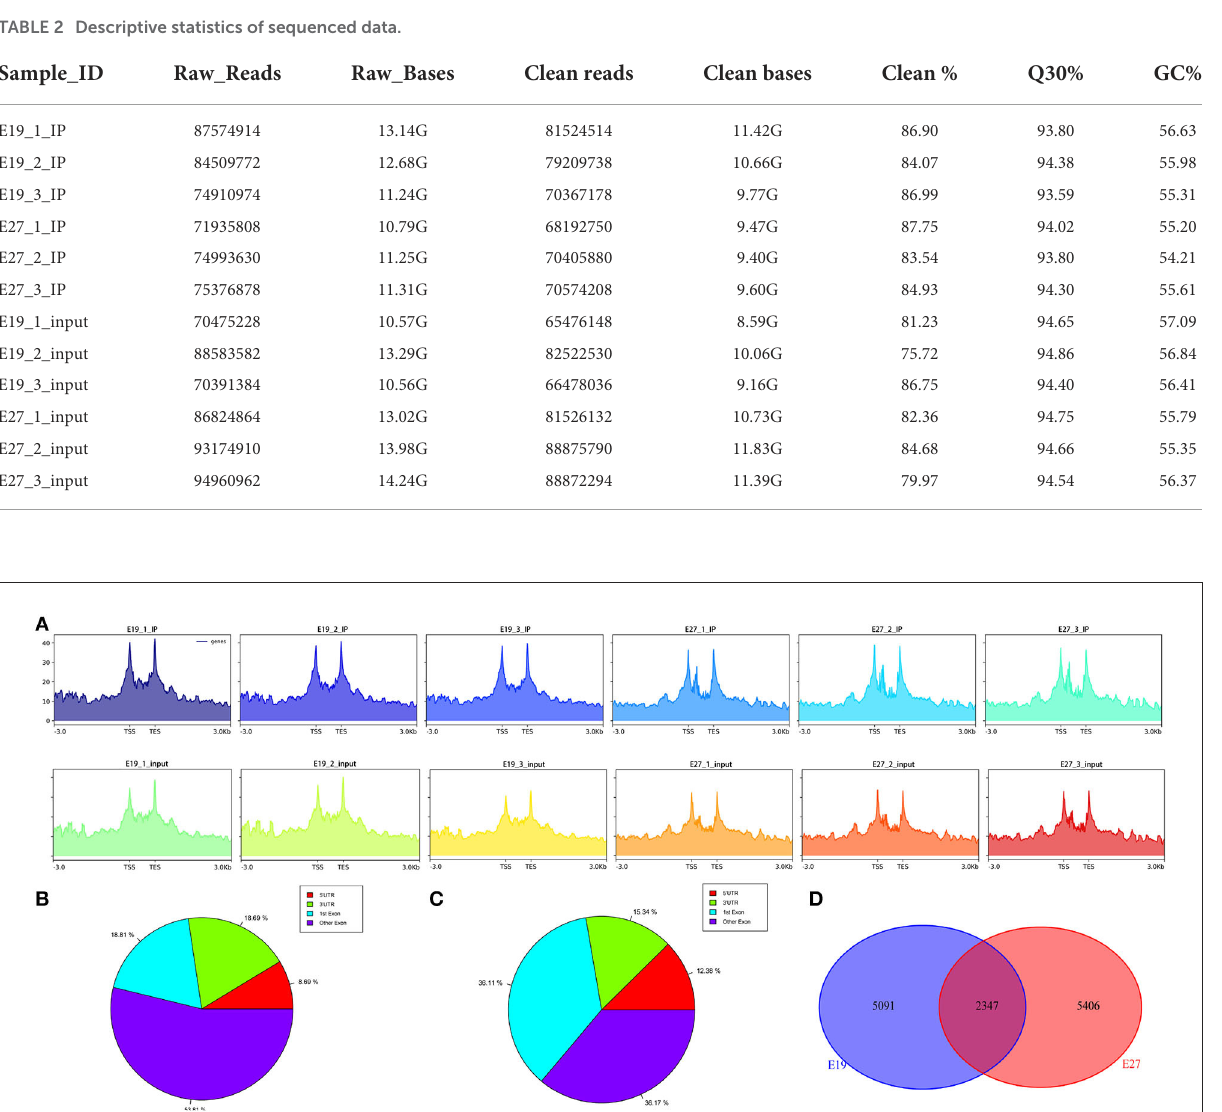
FIGURE2 Analysis of transcriptome-wide m6A-seq data. (A) Distribution of reads in the upstream and downstream 3kb range from the TSS–TES (transcription end sites). The abscissa is the gene location, and the ordinate is the coverage depth of reads. (B) Pie chart of m6A peaks at E19. (C) Pie chart of m6A peaks at E27. (D) Pie chart of unique and shared m6A peaks between E19 and